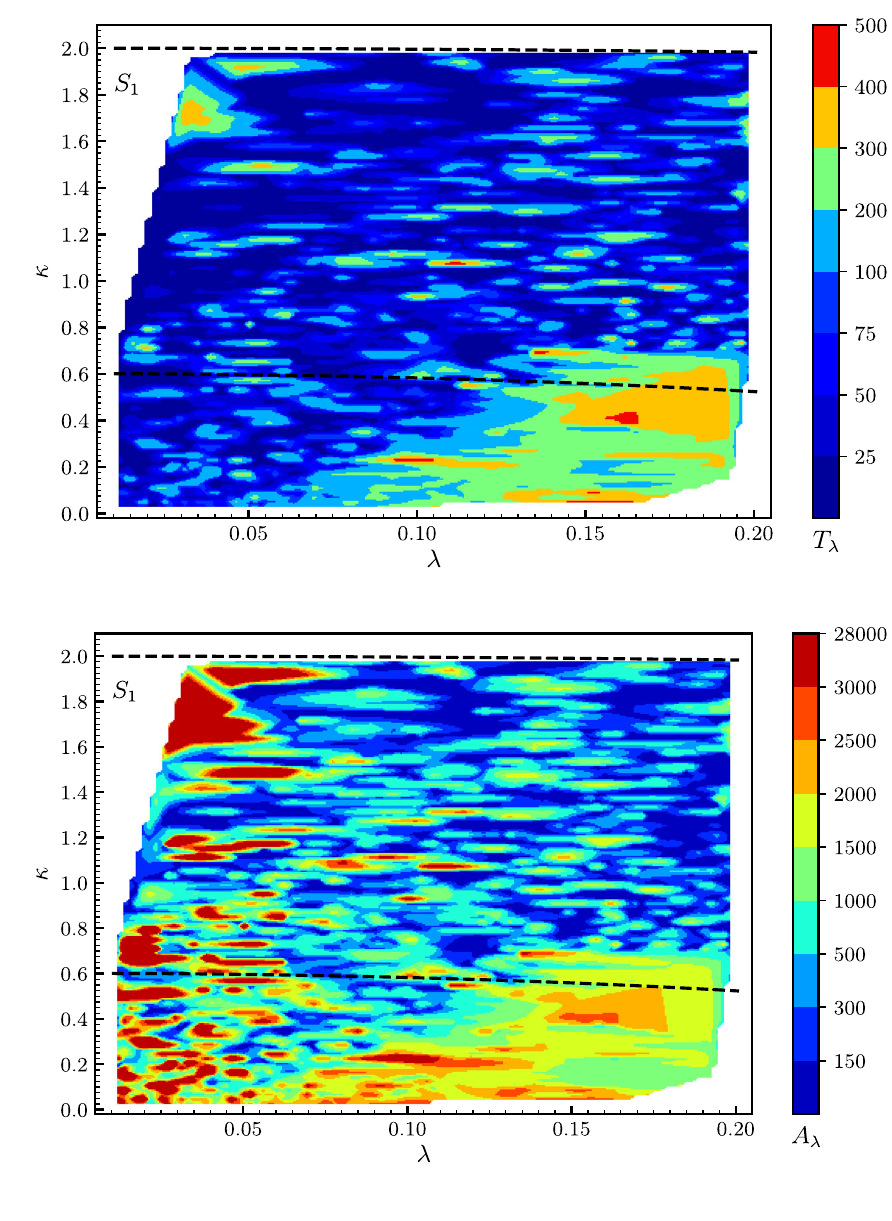
Fig. 18 The same as in Fig. 16, but the colours indicate different low-energy values of the trilinear soft terms T λ